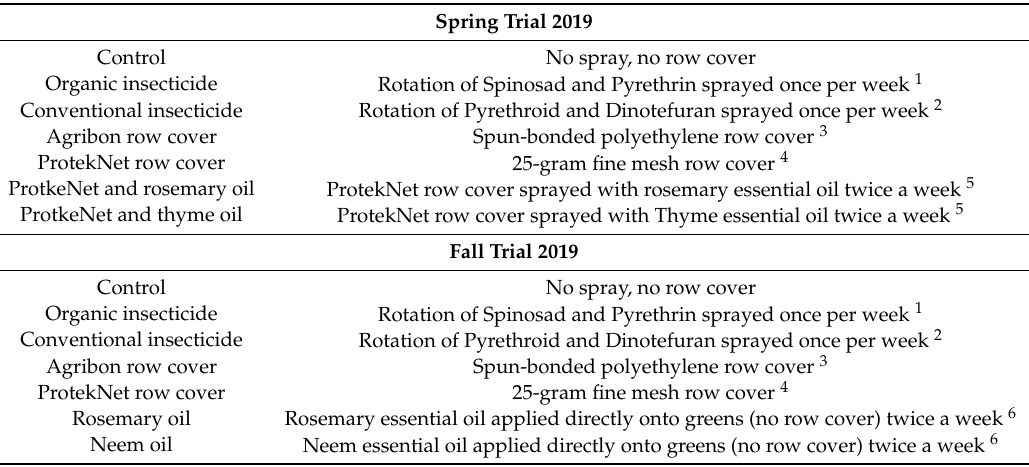
Table 1. Spring and fall treatment